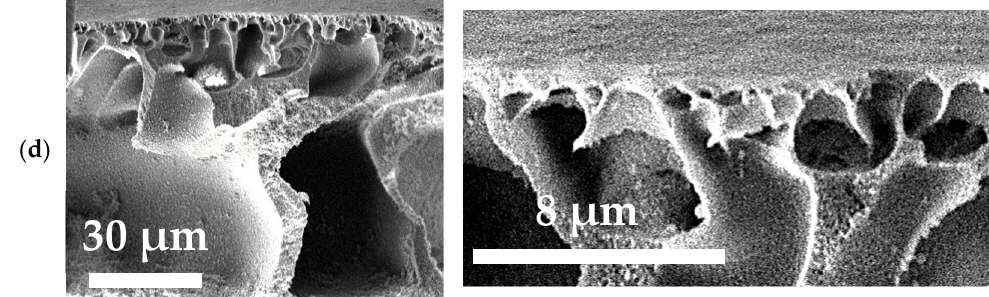
Figure 4. SEM cross-sectional micrographs of the membranes based on PA ( a ) and PA/TiO 2 (0.3 ( b ), 0.5 ( c ), and 0.75 ( d ) wt.%) composites.